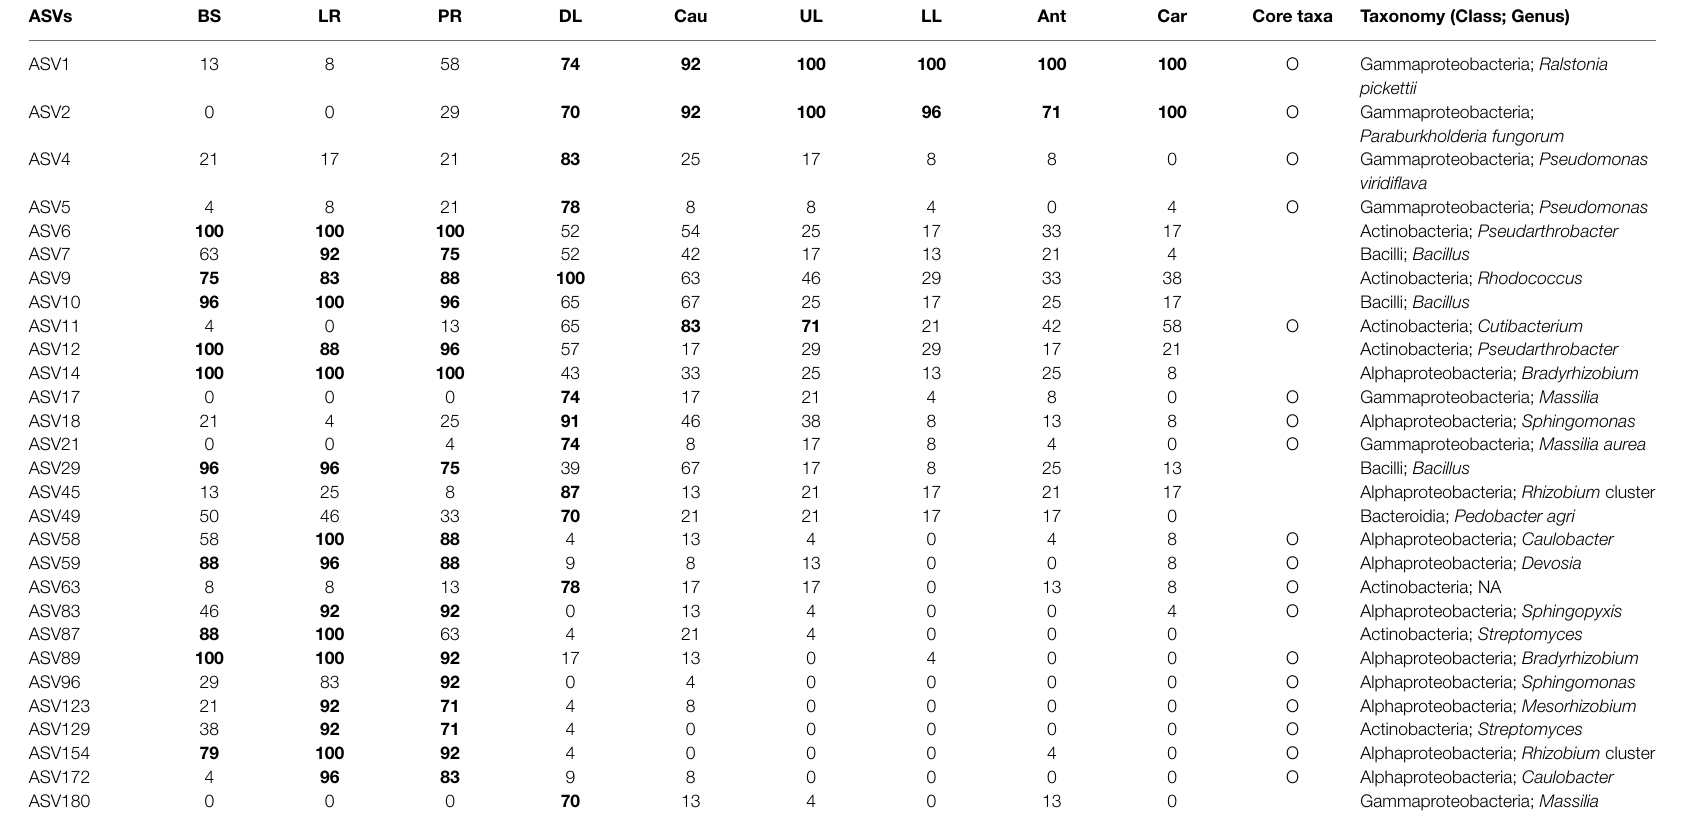
TABLE 2 | Appearance ratio (%) and taxonomy of ASVs according to holobiont components.